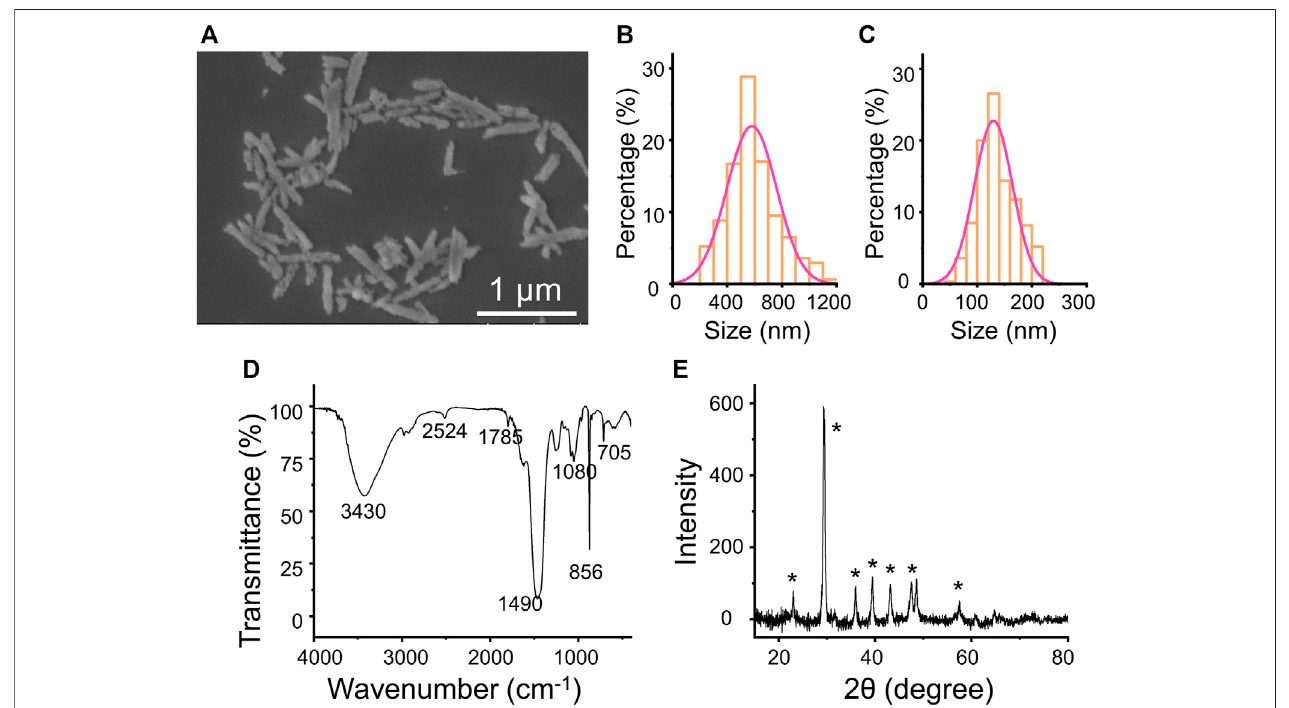
FIGURE 2 | (A) SEM images of the CaCO 3 NRs. (B) length and (C) width statistical chart of the CaCO 3 NRs. (D) FT-IR spectrum (E) XRD of CaCO 3 NRs.